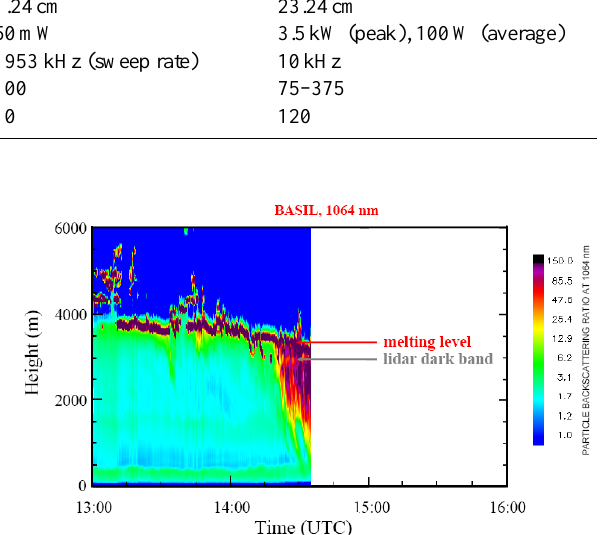
760 Figure 1. Time evolution of the particle backscatter ratio at 1064 nm from 13:00 UTC to 761 14:35 UTC on 23 July 2007 as measured by the Raman Lidar system BASIL. Arrows high- 762 Fig. 1. Time evolution of the particle backscatter ratio at 1064nm light the location of the melting level and the lidar dark band. 763 from 13:00UTC to 14:35UTC on 23 July 2007 as measured by the Raman Lidar system BASIL. Arrows highlight the location of the melting level and the lidar dark